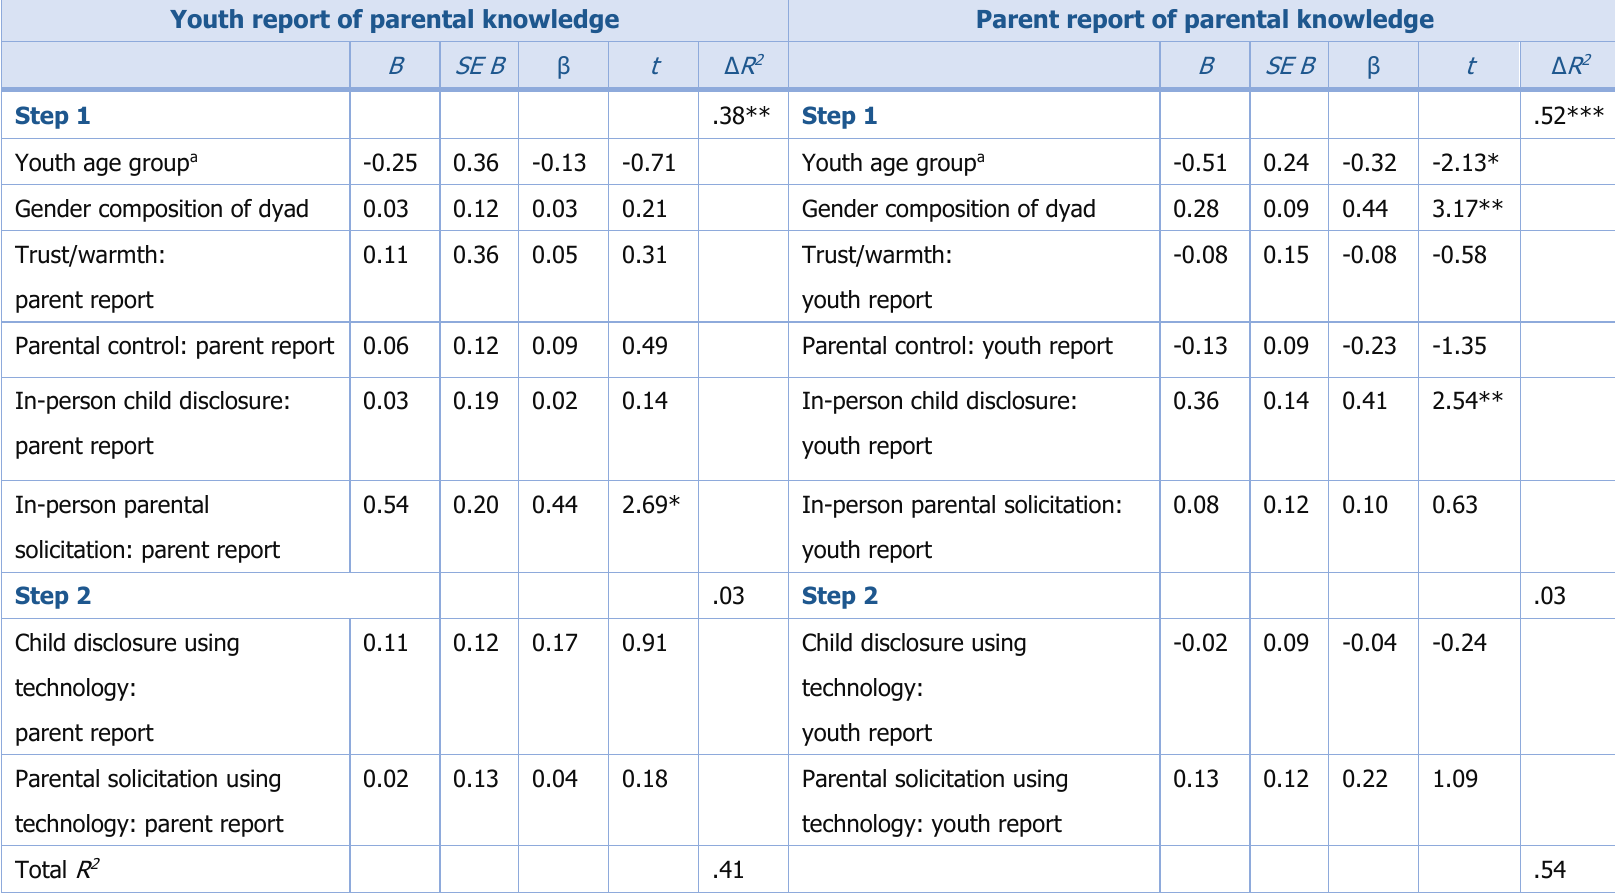
Table 3. Hierarchical Multiple Regression Analyses Examining Variance in Youth and Parent Report of Parental Knowledge Accounted for by Youth and Parent Report of Independent Variables Youth report of parental knowledge Parent report of parental